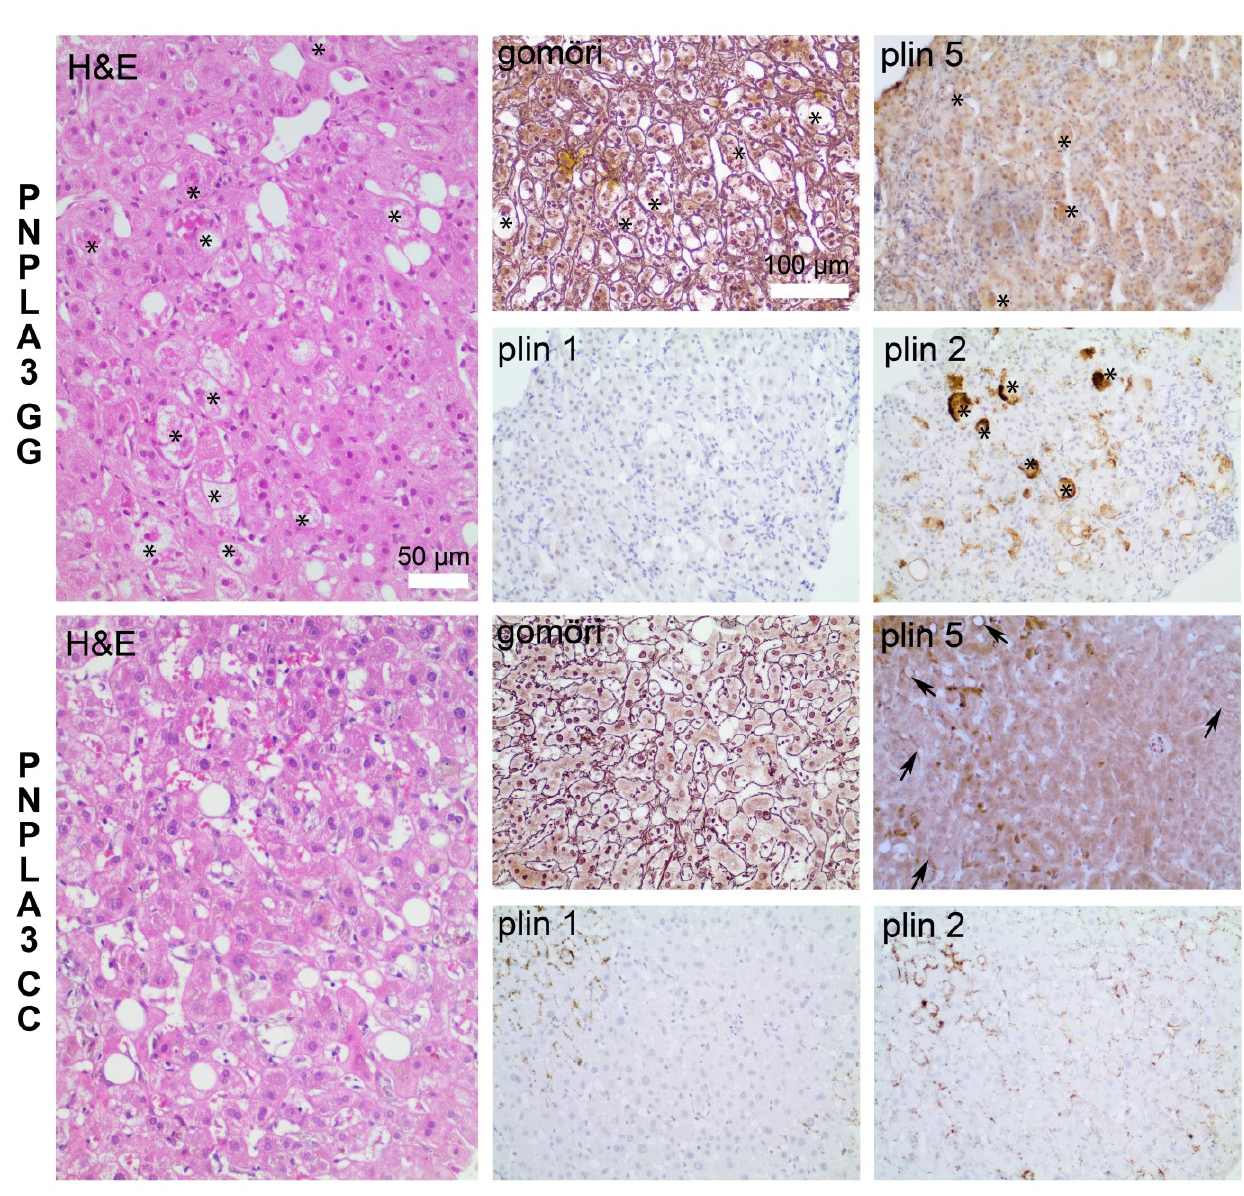
Figure A1. Immunohistochemistry of perilipins in liver biopsies of ASH patients with different PNPLA3-polymorphisms. Immunohistochemical images of perilipin 1, 2, 5, gömöri and H&E staining in a collective of 47 liver biopsies from ASH-patients with known PNPLA3 -status. In PNPLA3 G / G genotype, ballooned cells (asterisks) are more frequently detected, with strong positivity for perilipin 2 and reduced staining for perilipin 1 when compared with the PNPLA3 C / C genotype. Arrows depict LD- and granular staining of perilipin 5. Scale bars: 50 µm (H&E) and 100 µm (gömöri and immunohistochemistry).